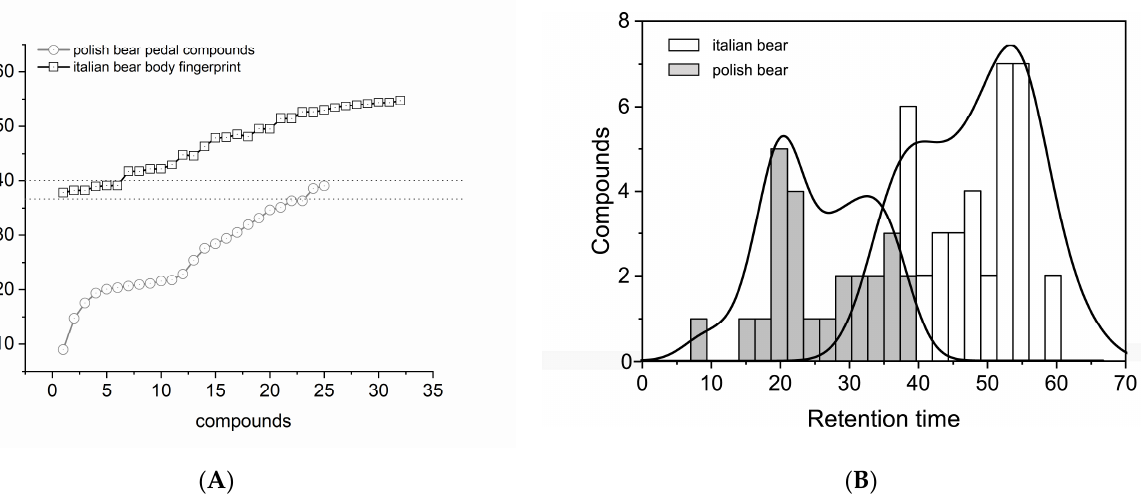
Figure 3. ( A ) Comparison of brown bear’s compounds extracted from polish population by pedal glands and Italian population by total body district; ( B ) distribution, density, and abundance com- parison.